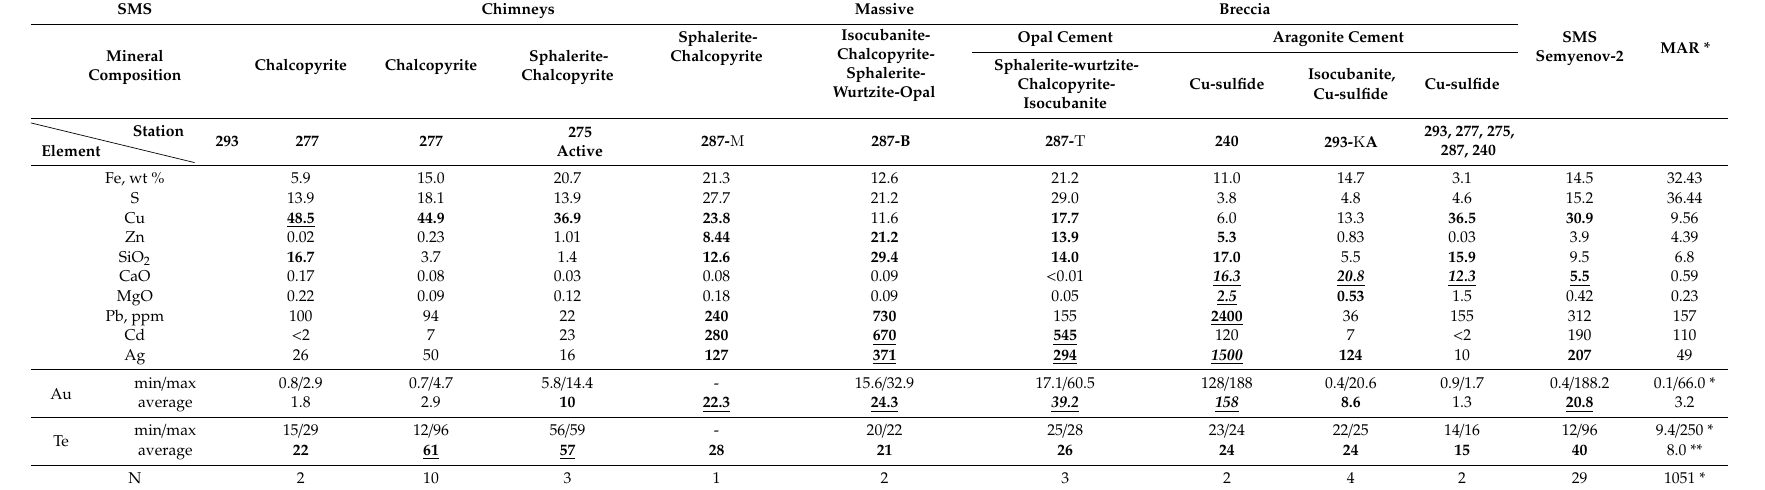
Table 10. Average bulk composition of SMS from